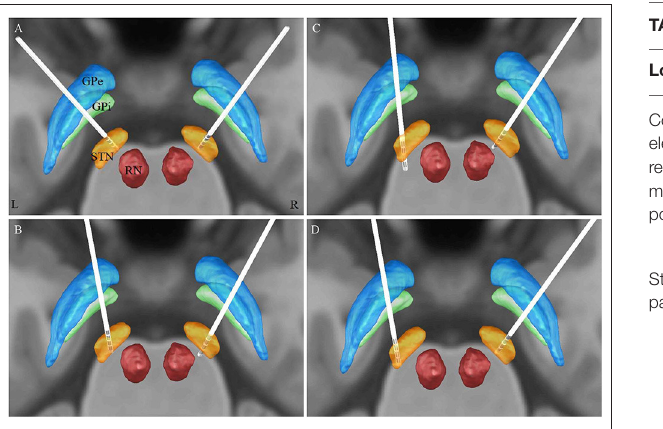
FIGURE 2 | 3D illustration for the localization of electrode contacts (Model 3389, Medtronic) by lead-DBS software: (A) patient 28, (B) patient 30, and (C) patient 41 (initial implantation): the left electrode of P28, the right electrode of P30, and the bilateral electrodes of P41 were implanted deeper than planning, and the most dorsal contact (contact 3) was located inside the STN; on the other hand, the right electrode of P28 and the left electrode of P31 were implanted as planning: contacts 0 and 1 were located inside the STN, contact 2 was located at the dorsal margin of the STN, and contact 3 was located above the STN. (D) patient 41 (after relocation).